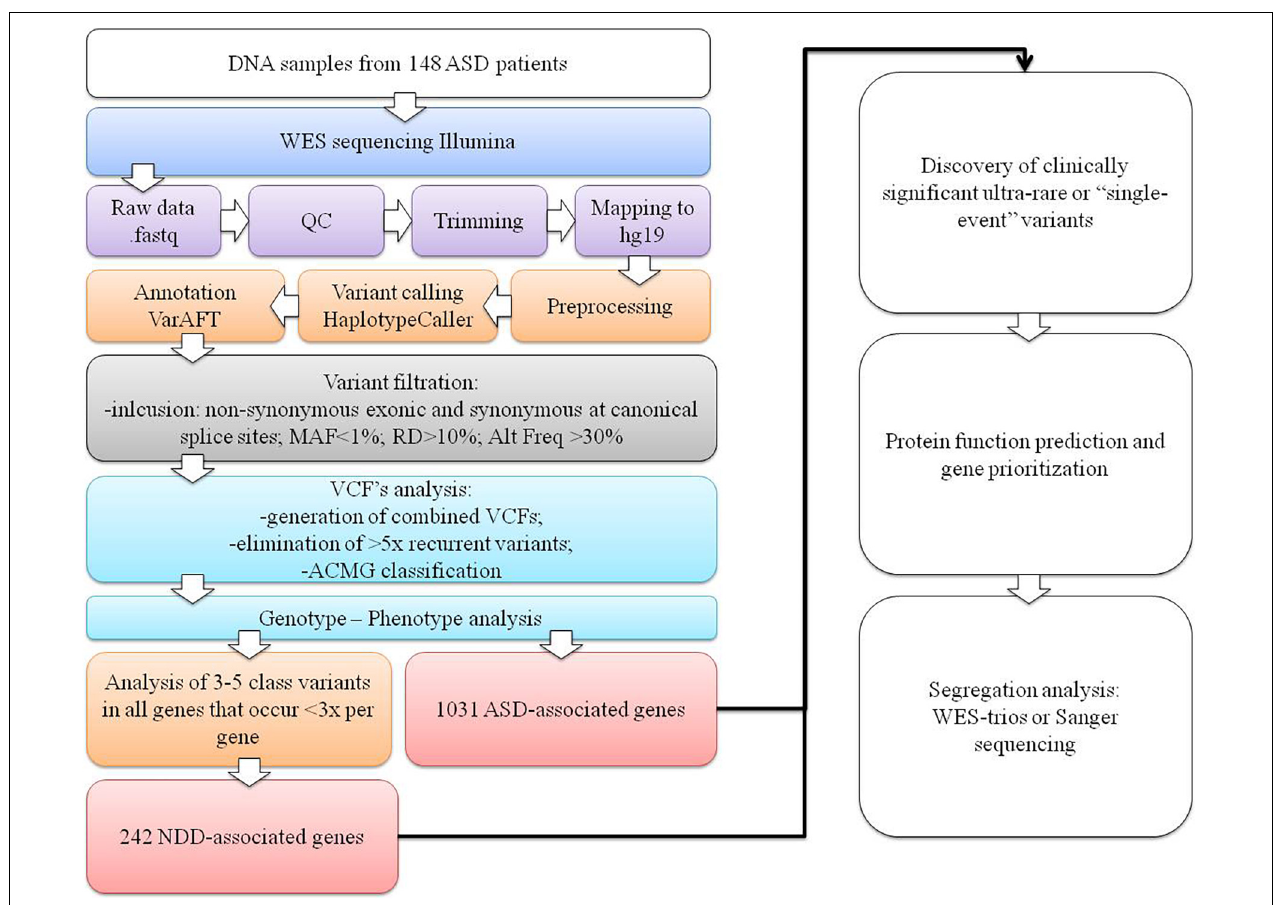
FIGURE 1 | The WES data variant analysis step-by-step workflow used in our cohort. The first section represents the NGS pipeline for generating VCF files. In the second section, variant filtering, identifying ultrarare or “single event” variants process, and data interpretation are presented.